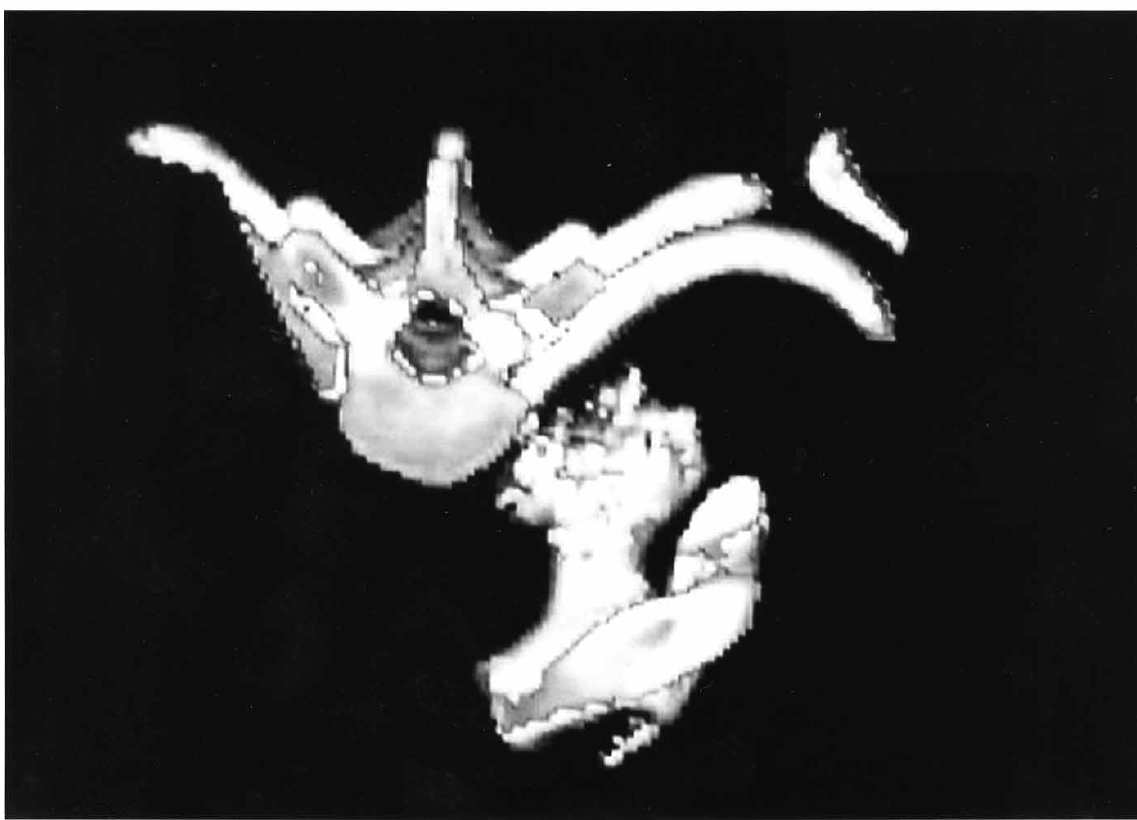
Fig. 1. Selected CT scan image showing a pedunculated chondrosarcoma arising from the medial end of the clavicle, with an irregular